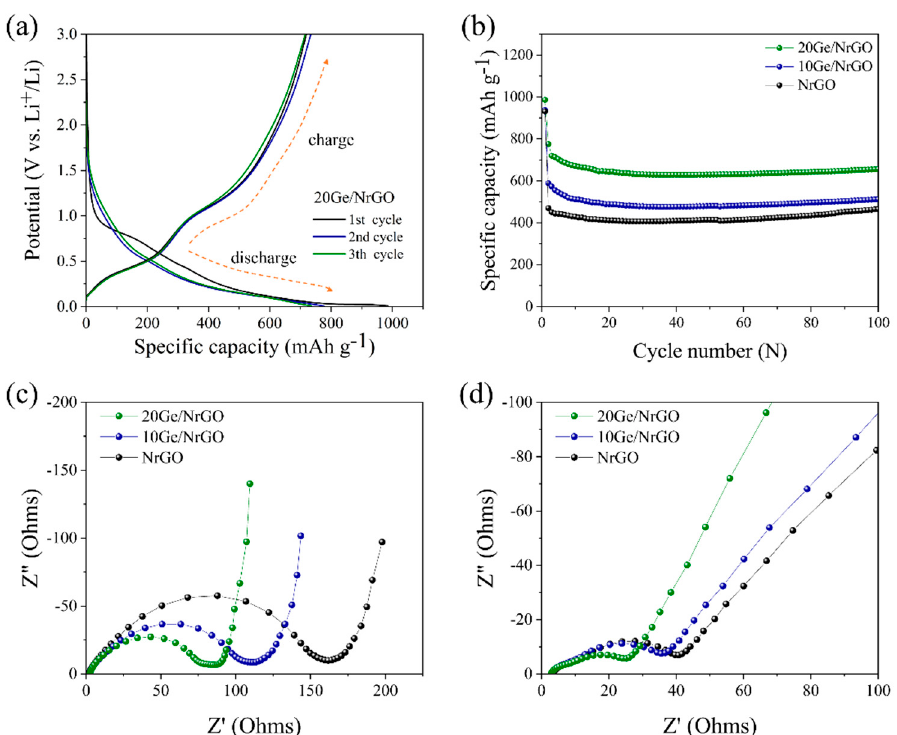
Figure 9. Electrochemical measurements; ( a ) Galvanostatic charge-discharge profiles of 20Ge/NrGO electrode for initial three cycles between 0.01 and 3.00 V vs. Li/Li + under the current density of 100 mA g − 1 , ( b ) Cycle performances at a current density of 100 mA g − 1 . Nyquist plots of prepared electrodes ( c ) before cycling and ( d ) 100th cycle over the frequency range from 100 kHz to 0.01 Hz.